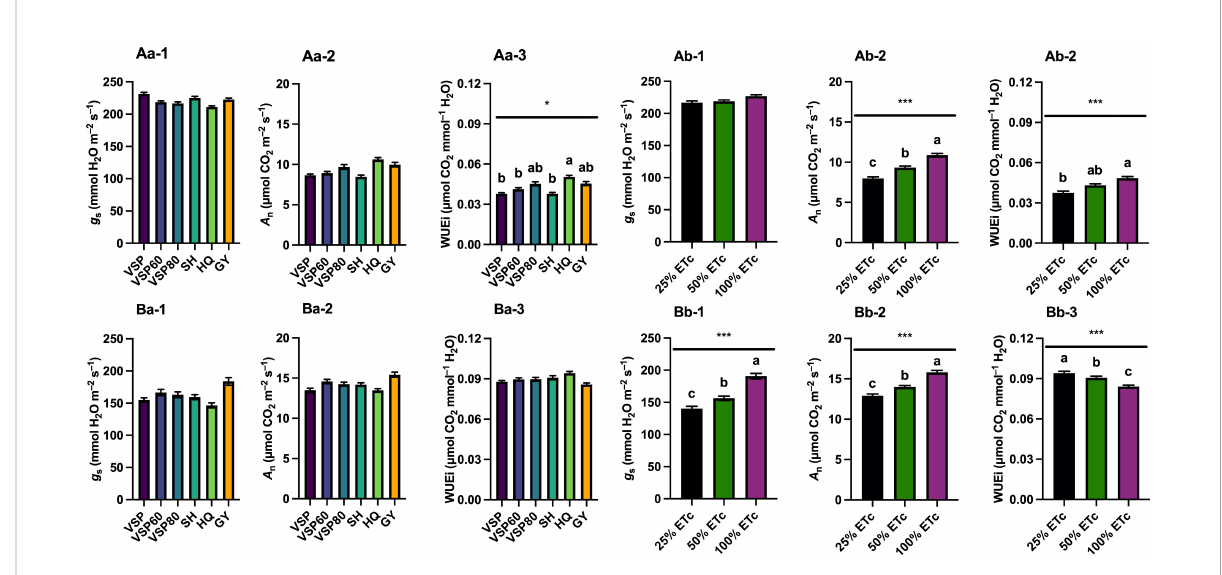
FIGURE 3 Season-long Leaf Gas Exchange Integrals as Affected by Trellis Systems and Applied Water Amounts of ‘ Cabernet Sauvignon ’ in Oakville, CA, USA in (A) 2020 and (B) 2021; (a) the main effect of trellis systems, (b) the main effect of applied water amounts; (1) stomatal conductance ( g s ), (2) net carbon assimilation rate ( A n ), (3) intrinsic water use ef fi ciency (WUE i ). Error bars represent one standard deviation from the mean, letters represent ranking after Tukey ’ s post hoc analyses. Asterisks represents signi fi cant levels p , ‘ *** ’ p < 0.001, ‘ * ’ p < 0.05. VSP, vertical shoot position; VSP60, vertical shoot position 60°; VSP80, vertical shoot position 80°; SH, single hire wire; HQ, High-Quadrilateral; GY, guyot-pruned vertical shoot position; ET c , crop